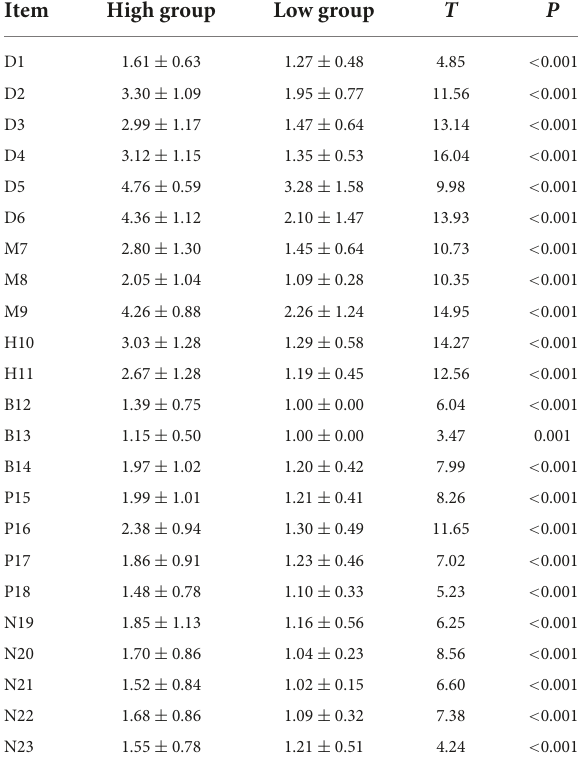
TABLE 1 Characteristics of the sample ( n = 432). TABLE 2 Item analysis for the Chinese version of SDSC-I ( n =